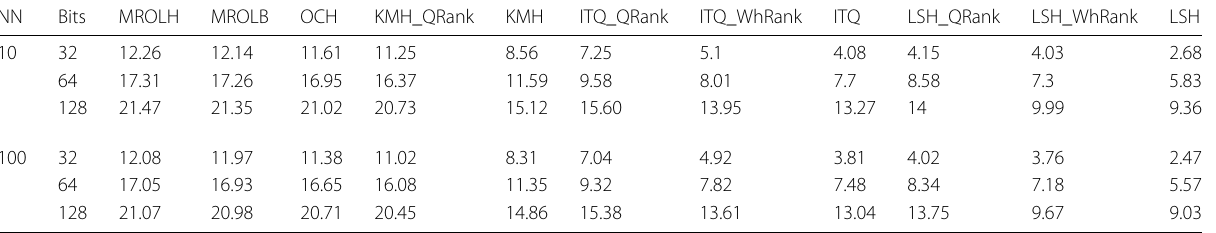
Table 1 The mAP ( % ) values of the comparative experimental results in the Cifar10 dataset NN